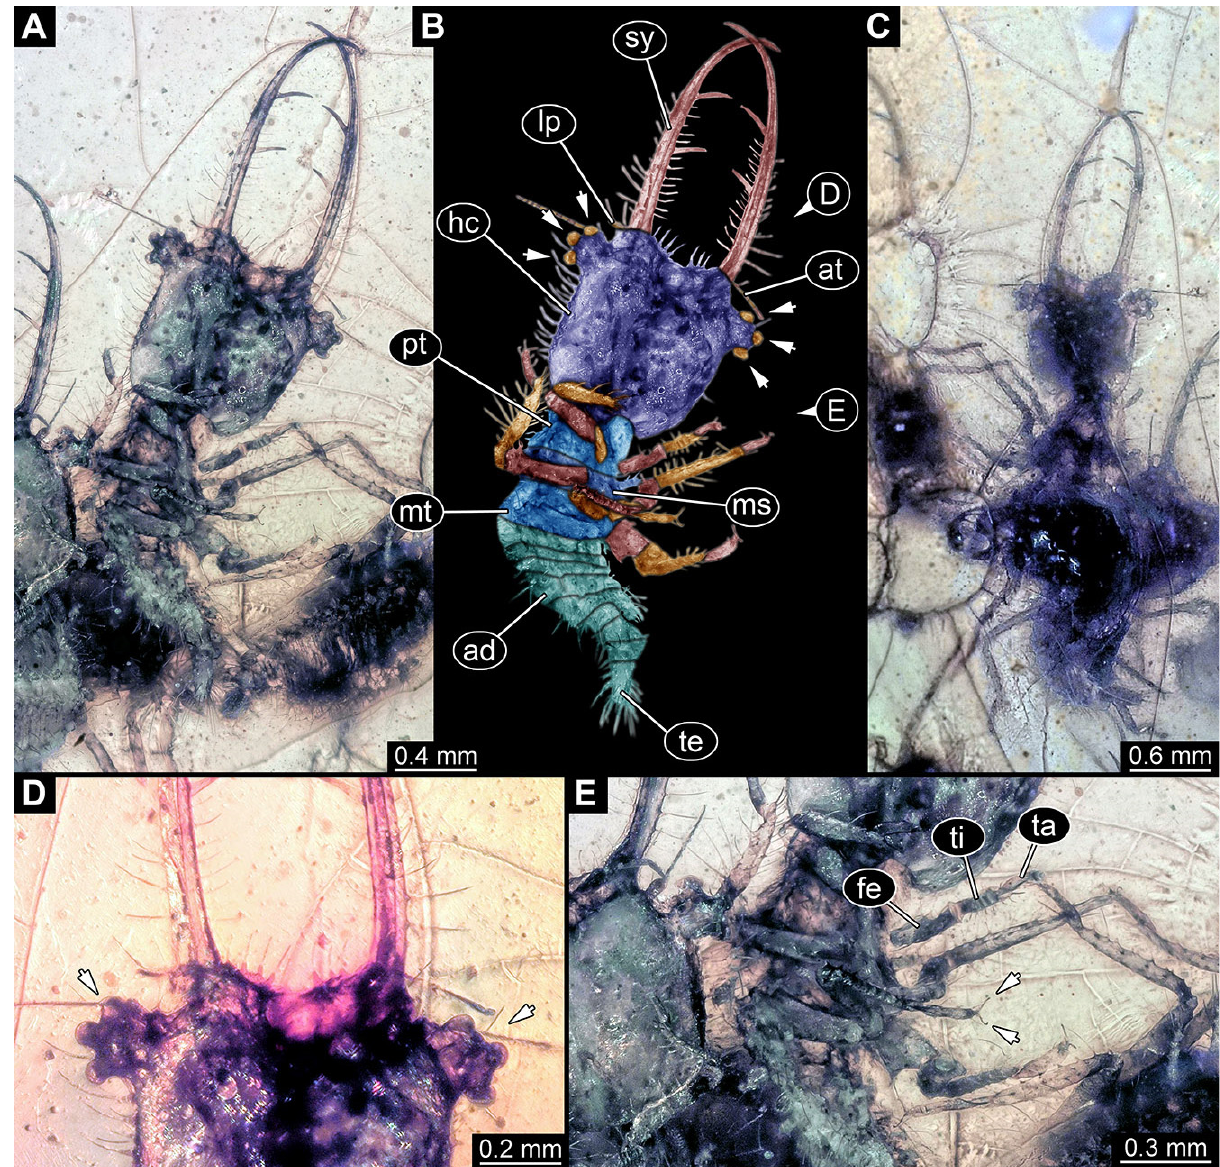
Figure 16. Fossil owllion larva, specimen 3229 (PED 0083c), Cretaceous Kachin amber, Myanmar. ( A ) Overview, ventral. ( B ) Color-marked version of ( A ); arrows point to stemmata. ( C ) Overview, dorsal. ( D ) Close-up on head capsule, with fields of stemmata (arrows). ( E ) Close-up on locomotory appendage with claws (arrows). Abbreviations: ad = abdomen; at = antenna; fe = femur; hc = head capsule; lp = labial palp; ms = mesothorax; mt = metathorax; pt = prothorax; sy = stylet; ta = tarsus; te = trunk end; ti = tibia.